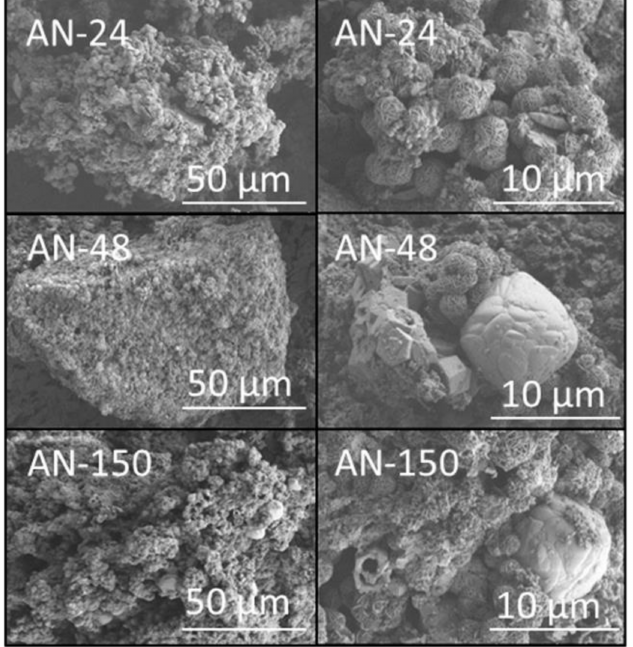
Figure 5. Secondary electron SEM images of hydrothermal products of amber container glass and aluminium nitrate (AN) synthesised for 24, 48 and 150 h in 4.5 M NaOH (aq) at 100 ◦